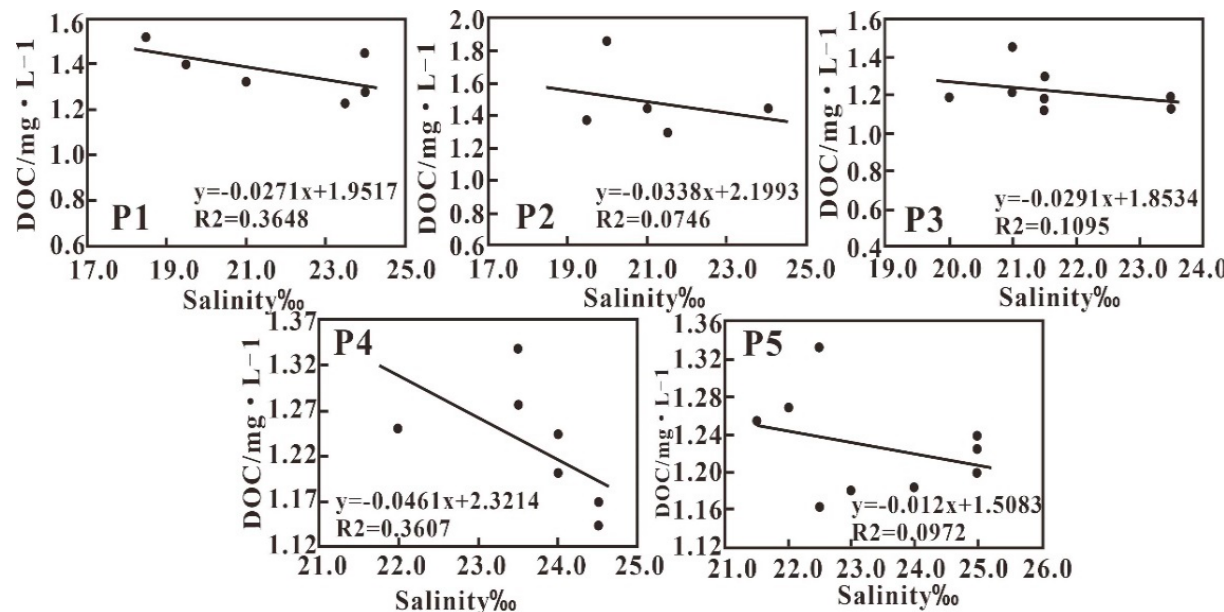
Figure 8. Distribution of measured DOC concentrations.